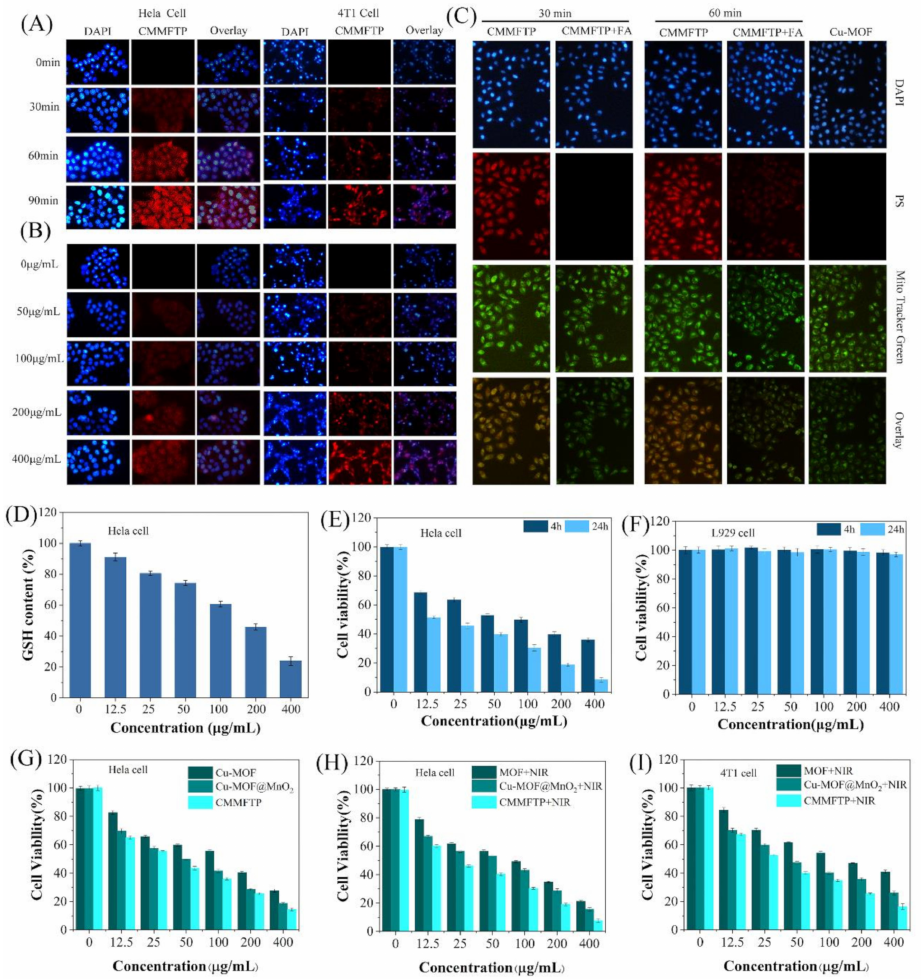
Figure 3. ( A ) Time (100 µ g/mL, 0–90 min) dependence and ( B ) concentration (30 min, 0–400 µ g/mL) dependence images of cell uptake; ( C ) detection of mitochondrial targeting of CMMFTP with Mito- Tracker Green; ( D ) detection of the intracellular GSH depletion capacity of CMMFTP; ( E ) dark toxicity of CMMFTP in Hela cells; ( F ) dark toxicity of CMMFTP in normal cells; ( G – I ) comparison of